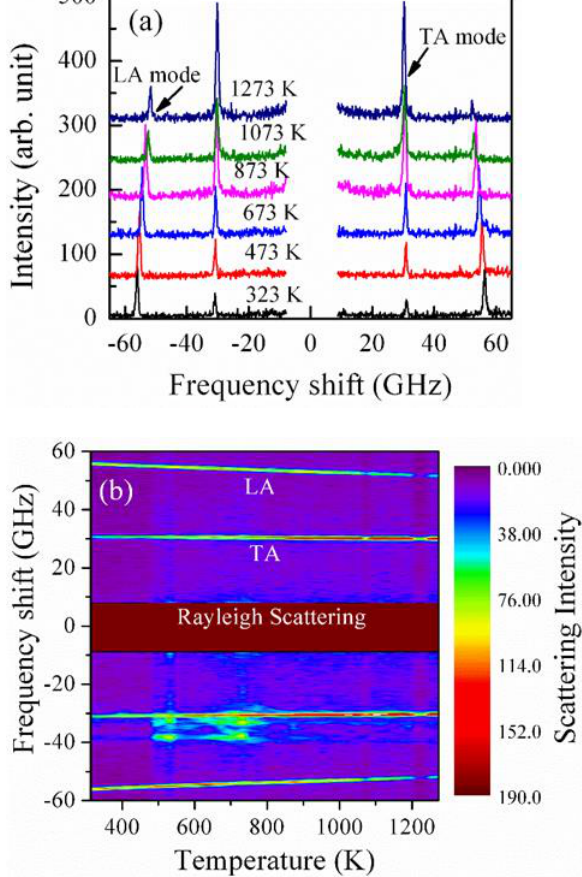
Figure 6. ( a ) A set of typical Brillouin scattering spectra at some selected temperatures and ( b ) a contour color map of intensity versus temperature and frequency of BZO single crystals [13].